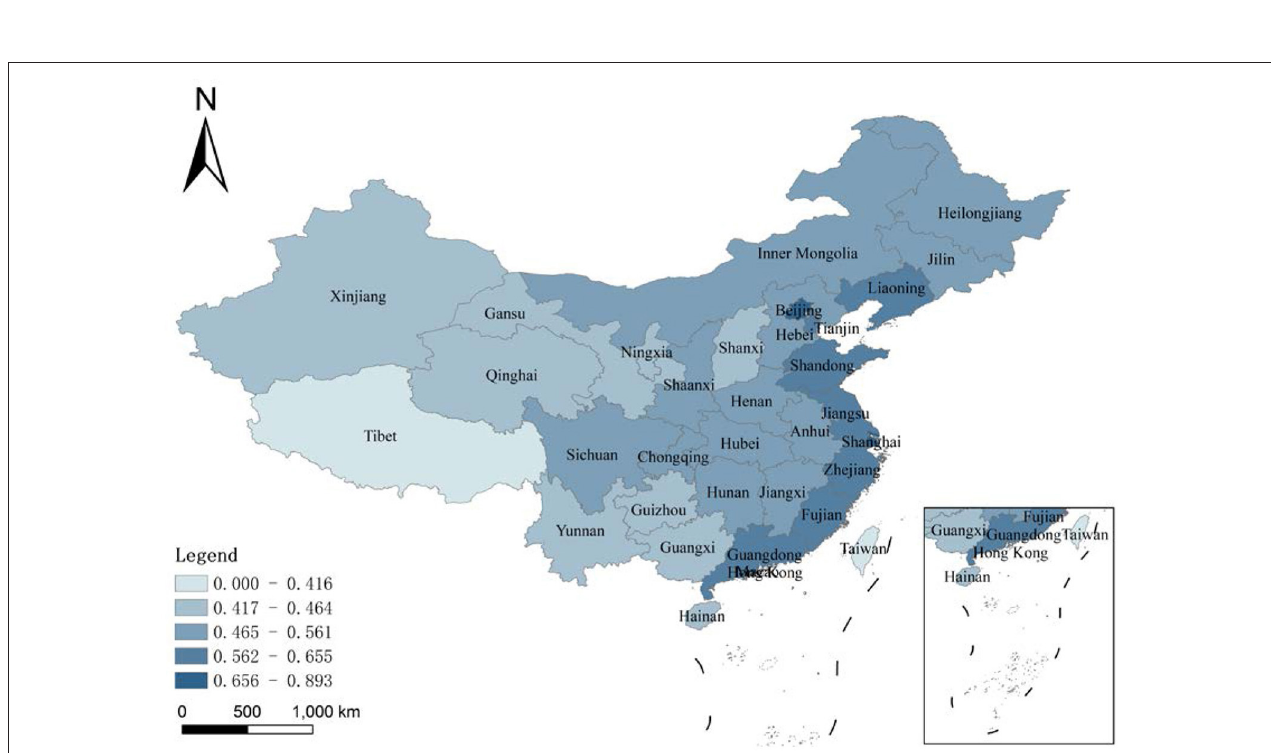
FIGURE 4 | Average innovation efficiency of the high-tech industry under the common frontier in 1999–2018.